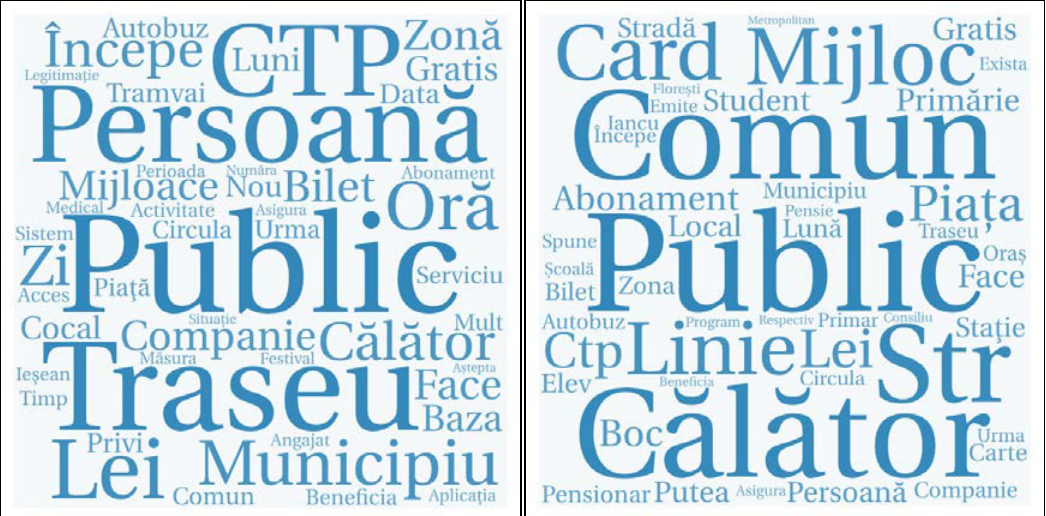
Figure 11: Most frequent 50 words in the case of Cluj - Napoca and Iași